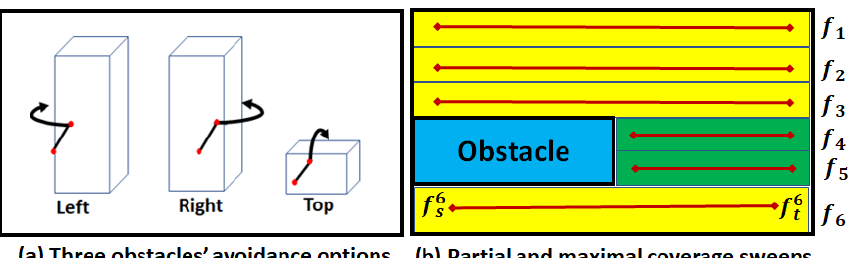
Figure 9. ( a ) Pictorial overview of the three obstacle avoidance options and ( b ) two types of